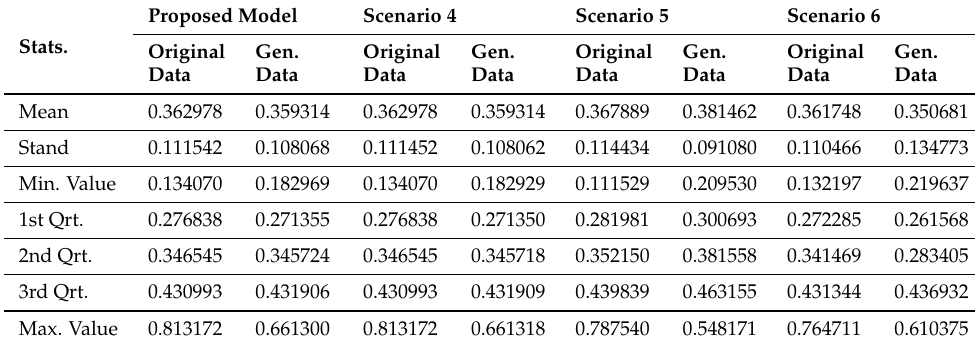
Table 9. Statistical